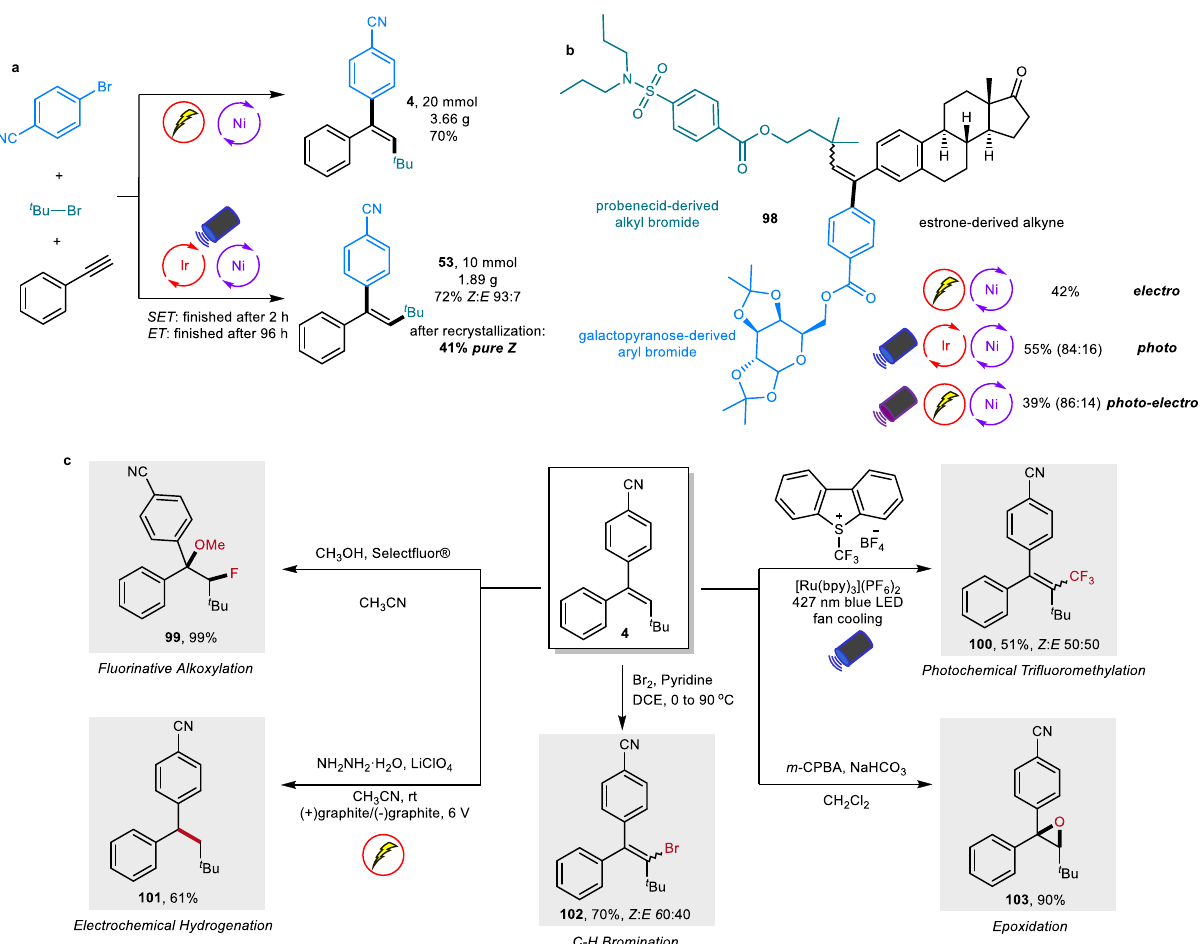
Fig. 5 Applications. a Scale up reactions for both the E and Z isomers. b Complex molecule synthesis via three different approaches. c Further functionalization of the generated trisubstituted